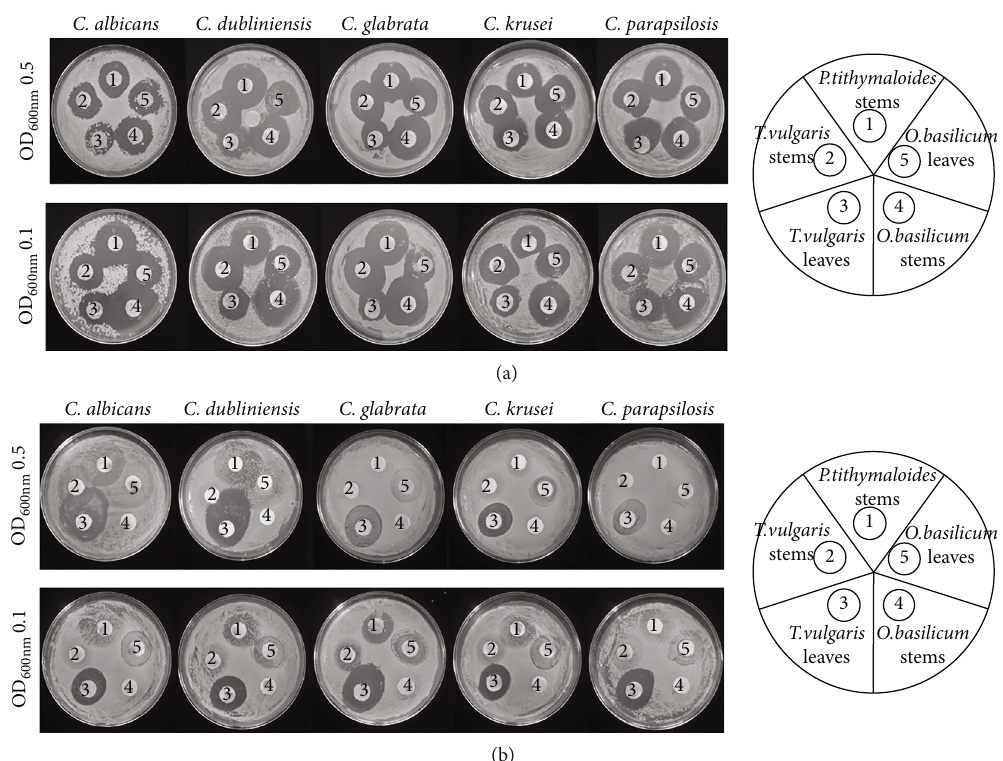
Figure 2: Susceptibility tests of stem or leaf extracts, obtained in (a) ethanol or (b) hexane, of P. tithymaloides , O. Basilicum , and T. vulgaris against C. albicans , C. dubliniensis , C. glabrata , C. krusei , and C. parapsilosis .